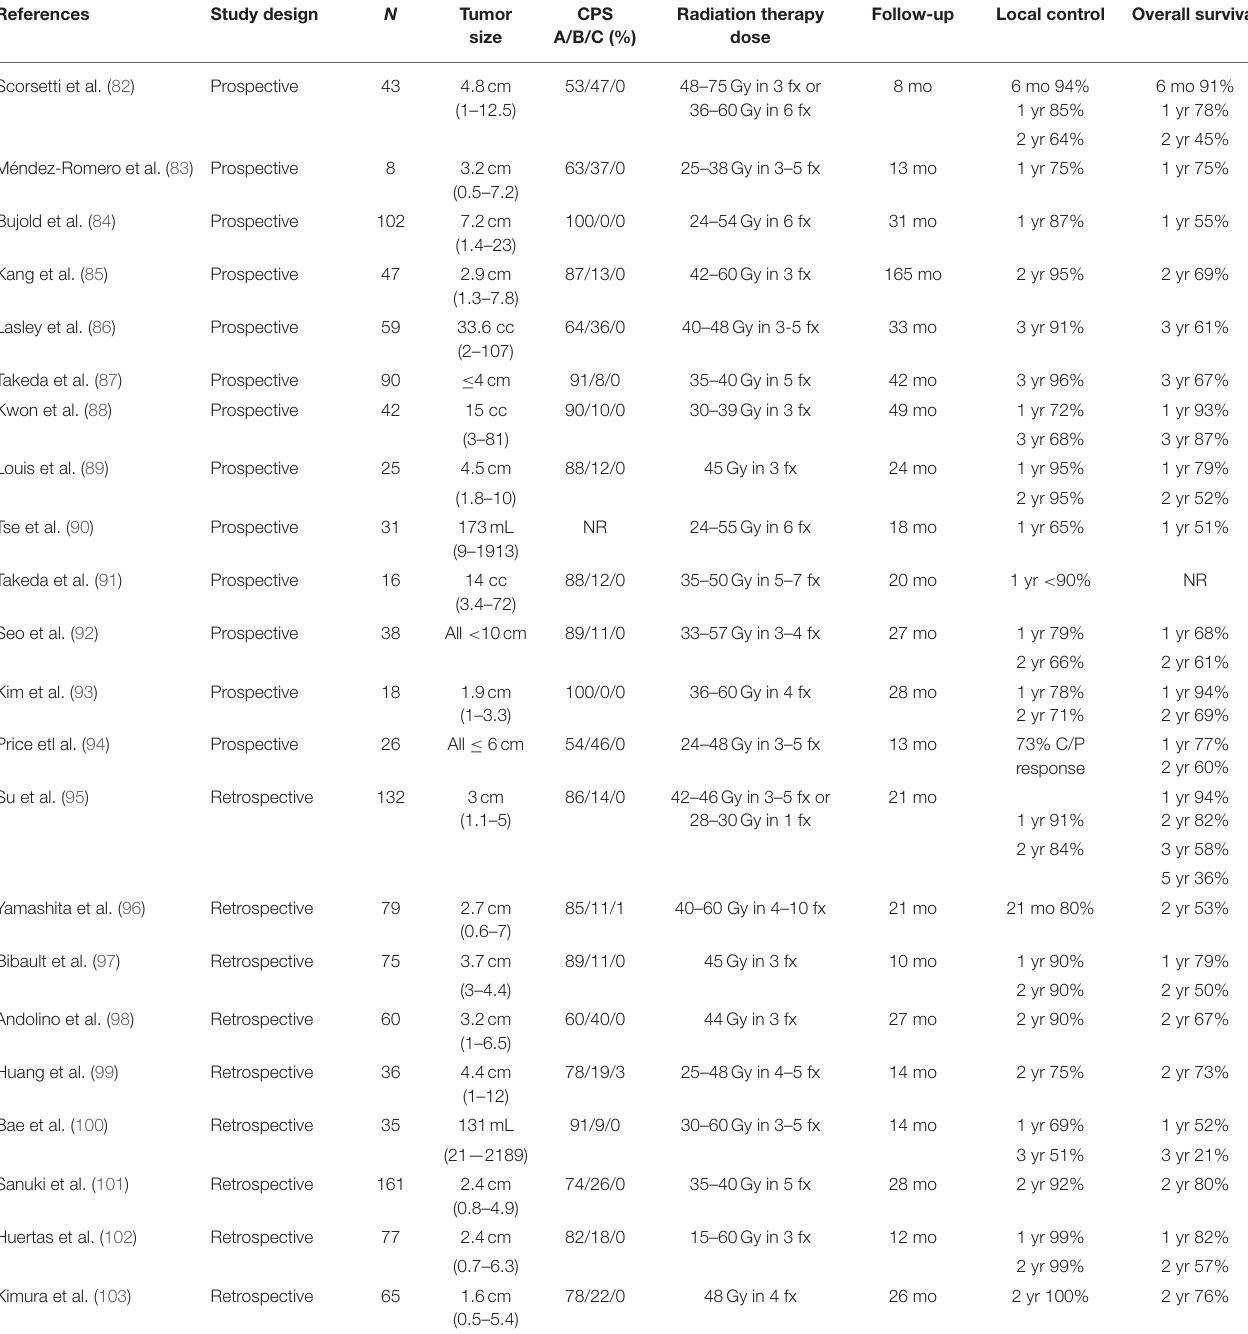
TABLE 5 | Studies of stereotactic body radiation therapy for hepatocellular